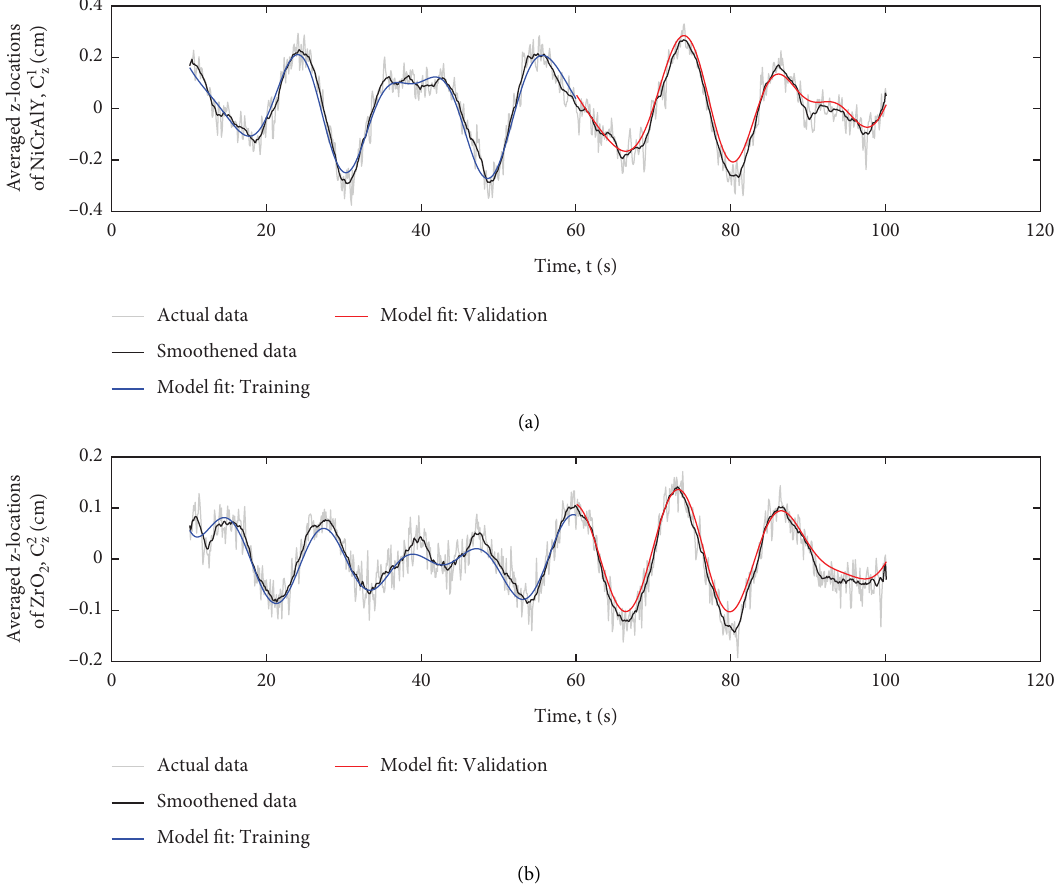
Figure 9: Responses of the models in equation (3) are compared with the smoothened data of (a) the averaged z – locations of NiCrAlY particles (ft � 79% (81%) for training (validation)) and (b) the averaged z – locations of ZrO 2 particles (ft � 74% (83%) for training (validation)).